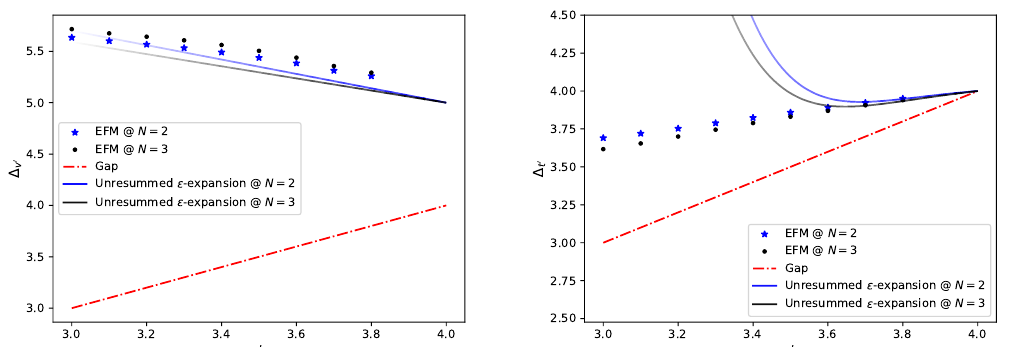
Figure 5: Subleading operators in 4 of the 5 channels where gap assumptions were made (continues in fig. 6). Left: Spin-0 V channel. The larger discrepancy with the ε -expansion (the operators even appear in the opposite order as they do in the ε - expansion) is not surprising for operators with large twist in a setup with relatively low Λ . Right: Spin-0 T